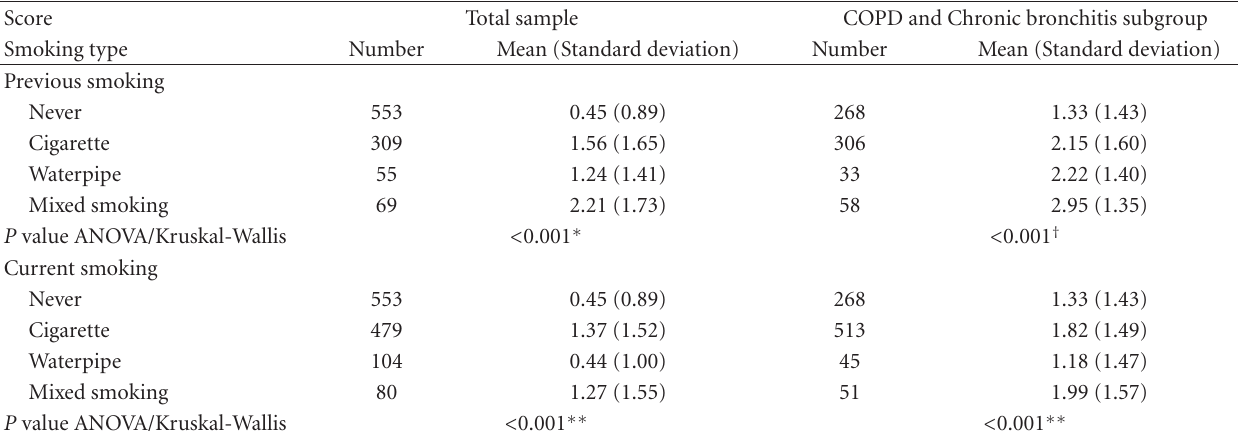
Table 4: Quality of life, obstructive diseases, and smoking